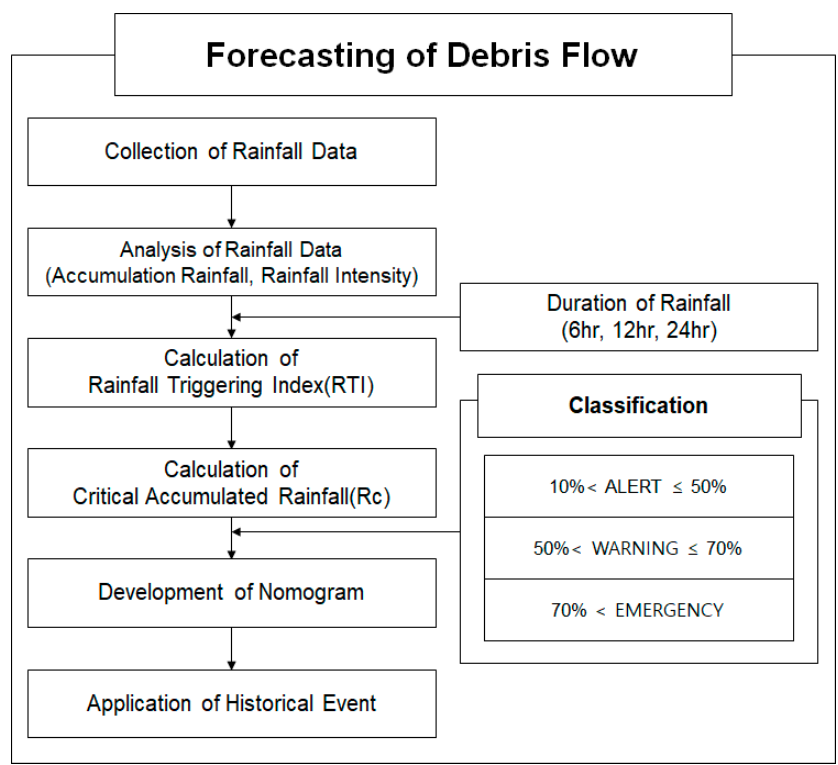
Figure 1. Flowchart for debris flow forecasting.